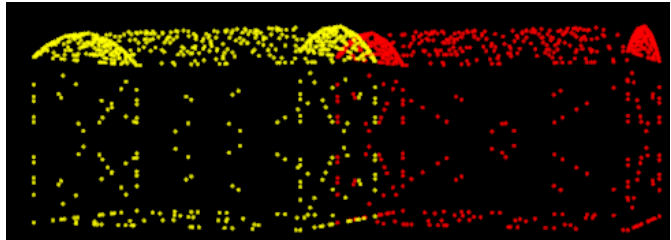
Figure 5. Example of a generated source point set (red) and generated target point set (yellow) for the iterative closest point (ICP) algorithm.